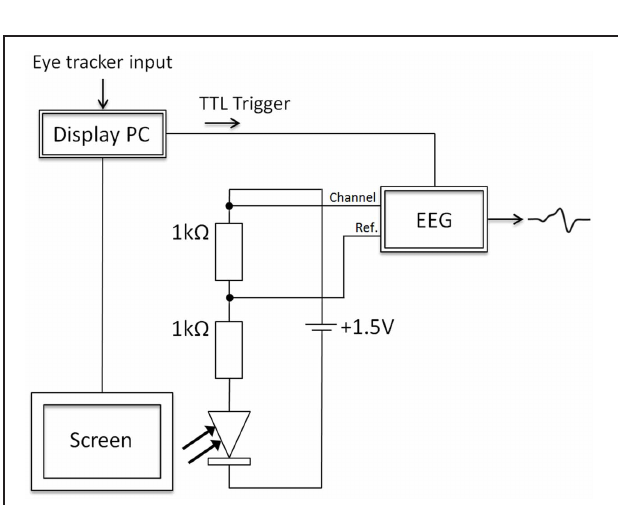
FIGURE 4 | The electronic circuit, which was used to measure the display change latency, involved two resistors (1k (cid:2) ), a voltage source (battery; 1.5V), and one photosensitive diode. The diode was placed either on a black square on the monitor or in front of projector 2, which was switched off before the boundary was crossed. After the boundary cross, the light intensity at the photosensitive diode was increased by removing the black square or switching on projector 2. This difference in illumination was measured by the photosensitive diode and allowed assessing the display change latencies in all setups (projector, monitor 150Hz, and monitor 200Hz